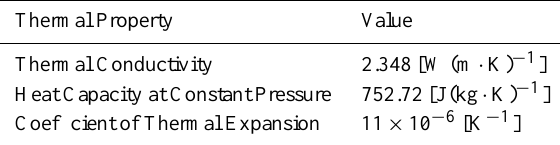
Table 2. Thermal Property of Host